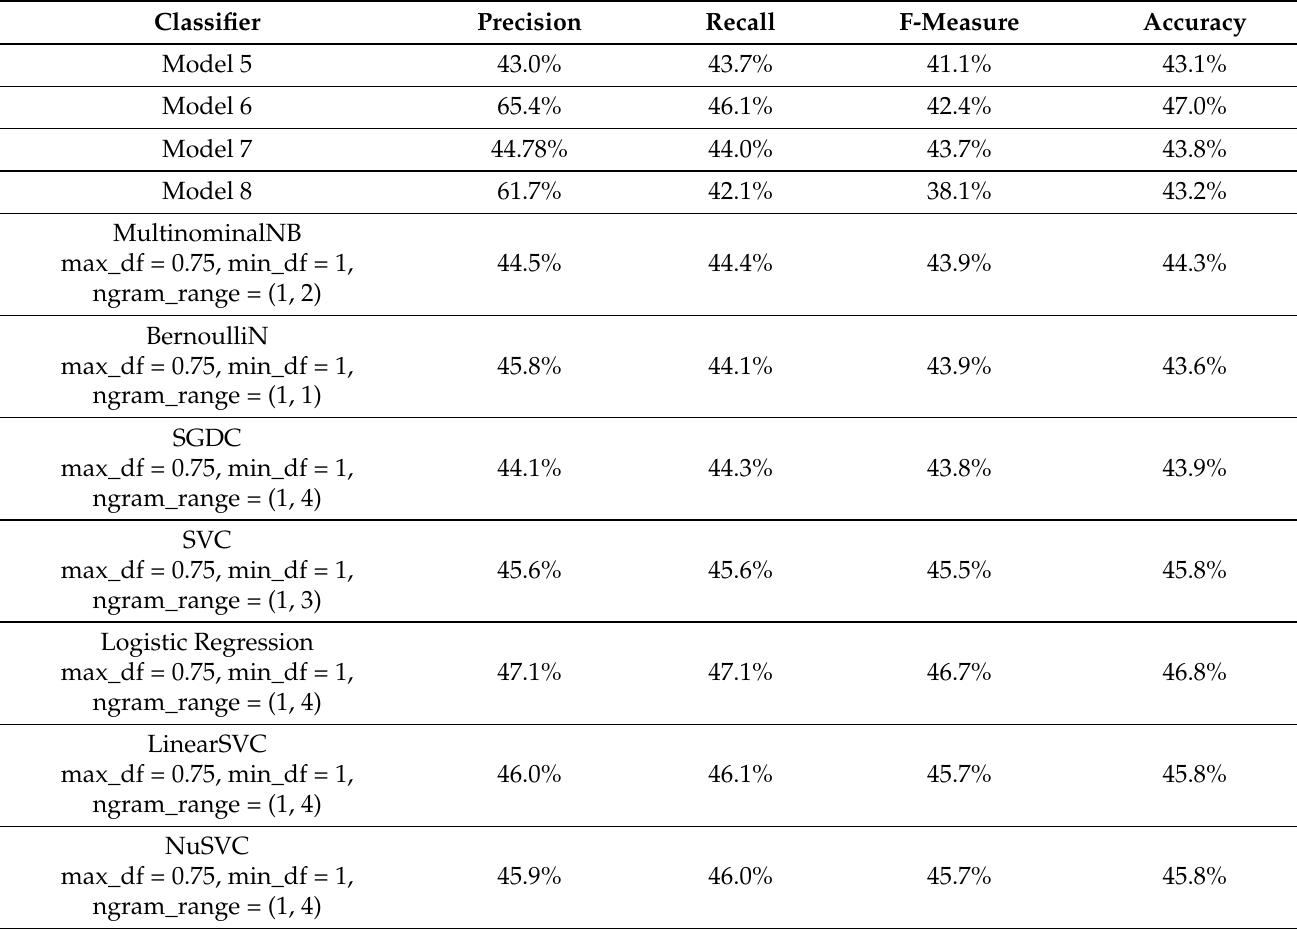
Table 5. Results of three-way ADI problem (classes 1 and